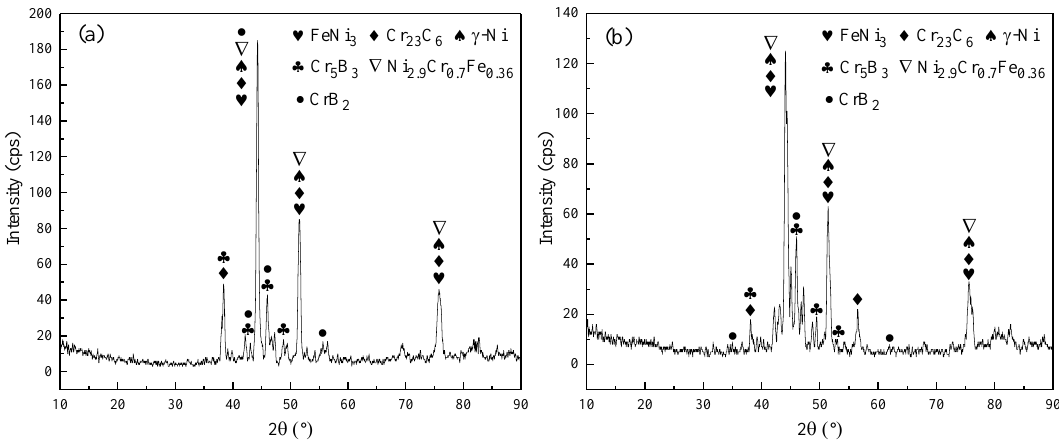
Figure 10. The analysis results of the energy dispersive spectrometer of the cladding layer. ( a ) EDS analysis of point a ; ( b ) EDS analysis of point b ; ( c ) EDS analysis of point c ; ( d ) EDS analysis of point d .